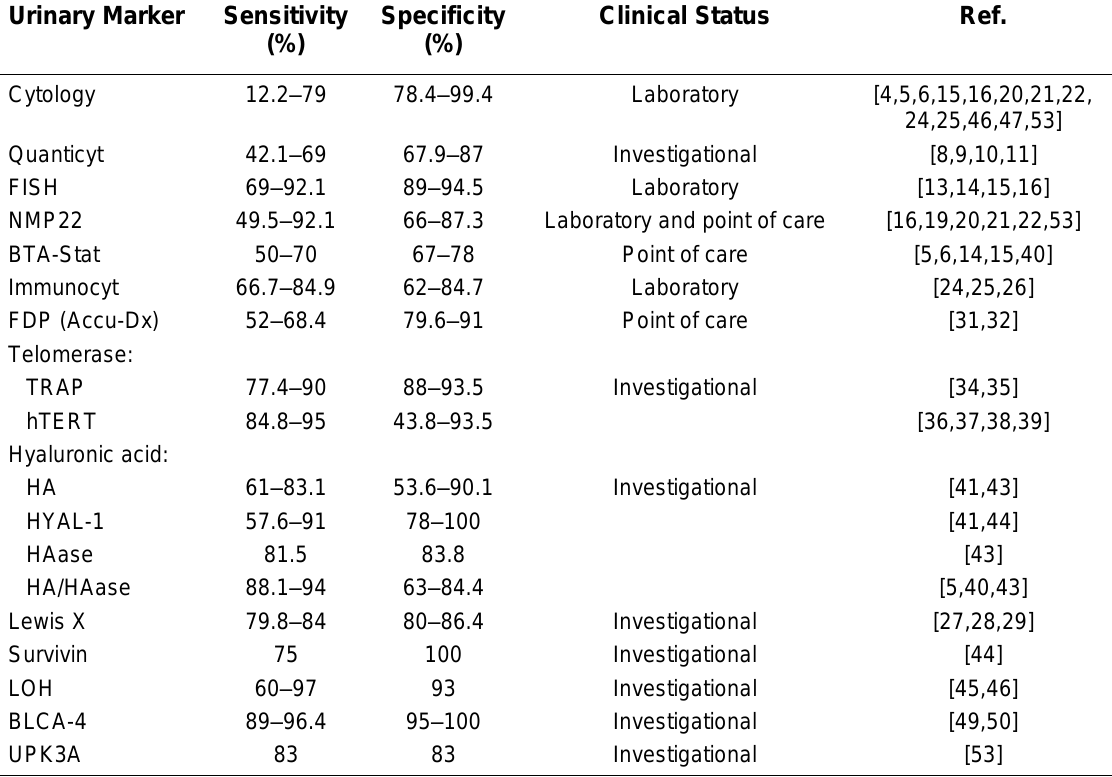
Summary of Urinary Markers and Their Performance Based on Scientific